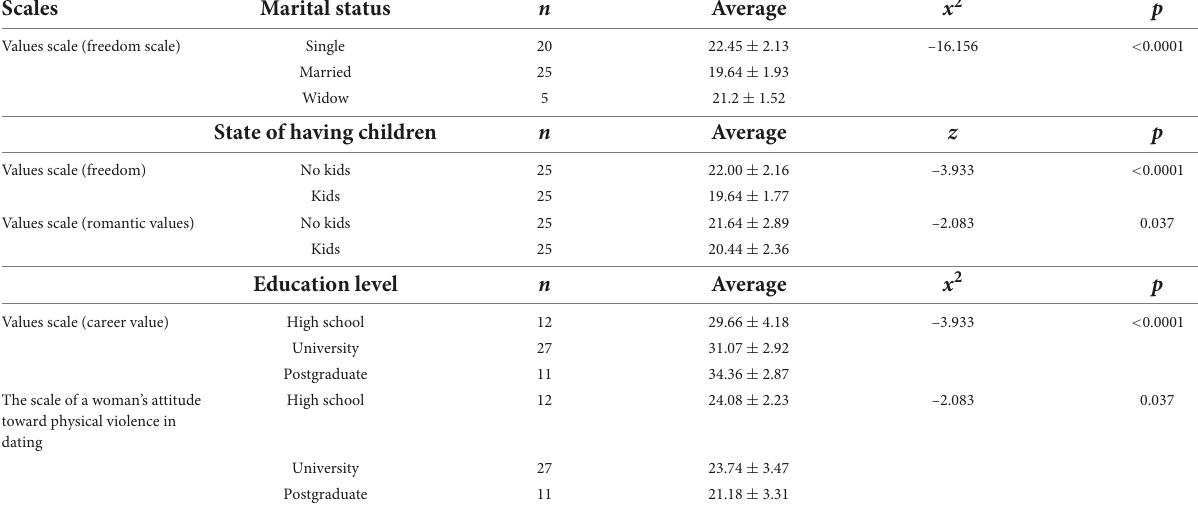
TABLE 1 Relationship between marital status, having children, and education level with related scales.